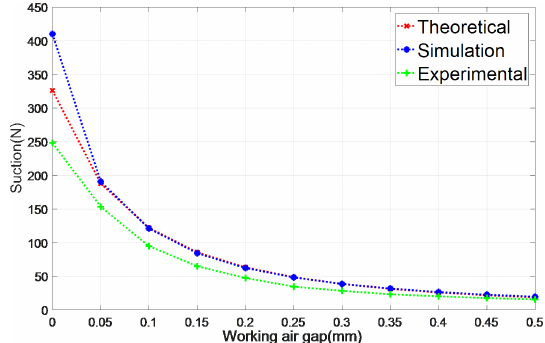
Figure 16. Relationship between working air gap and suction for theoretical, simulation and experimental results.